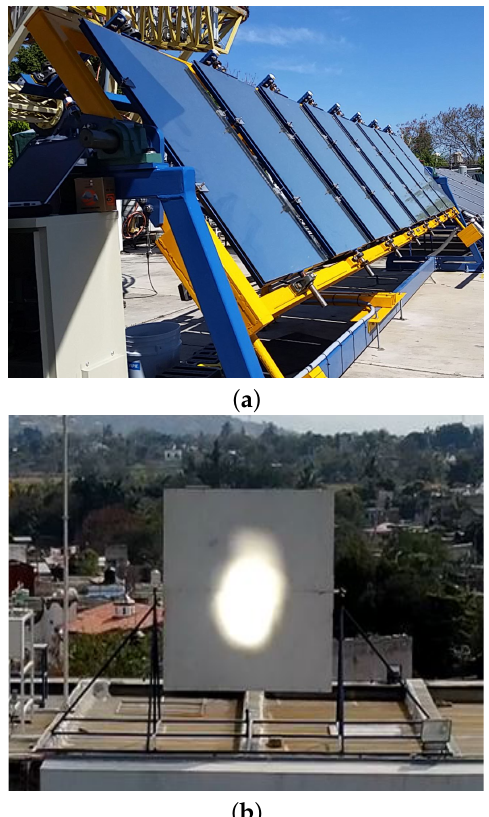
Figure 15. Photographs of the heliostat array prototype ( a ), and the concentrated solar flux distribution reflected on the target ( b ).